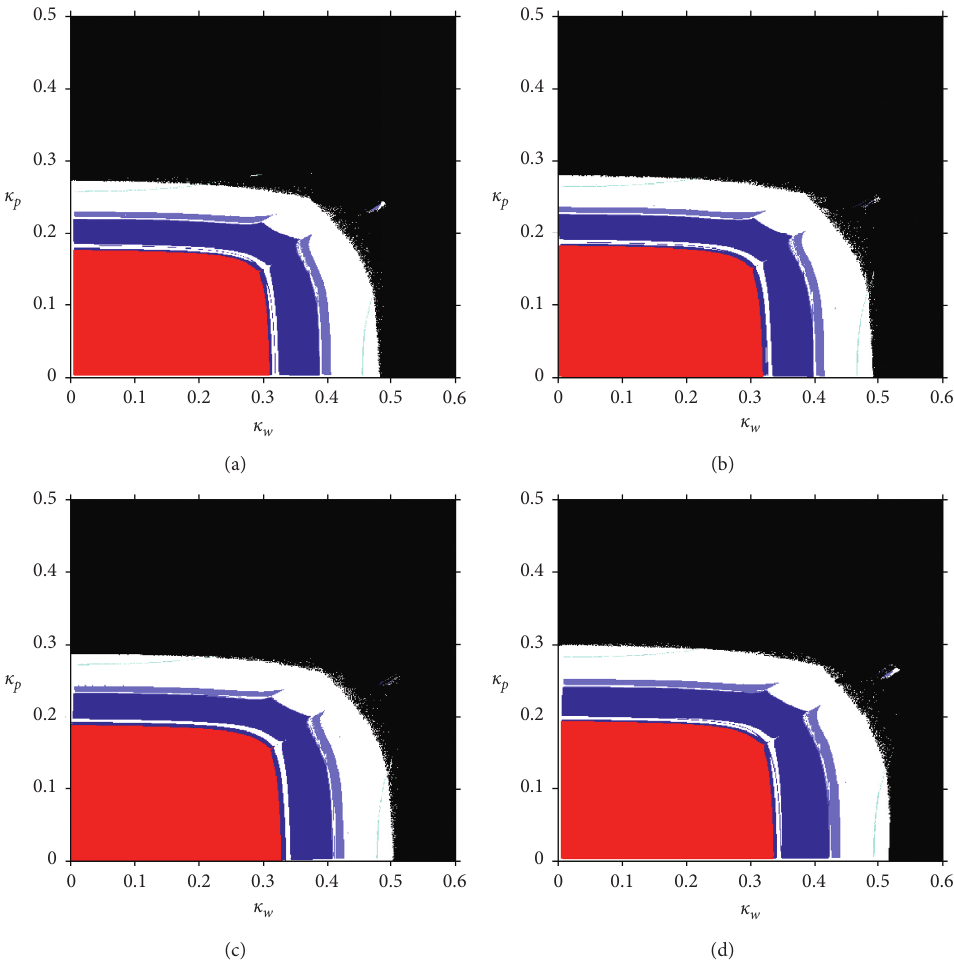
Figure 5: 2D bifurcation diagrams with respect to κ